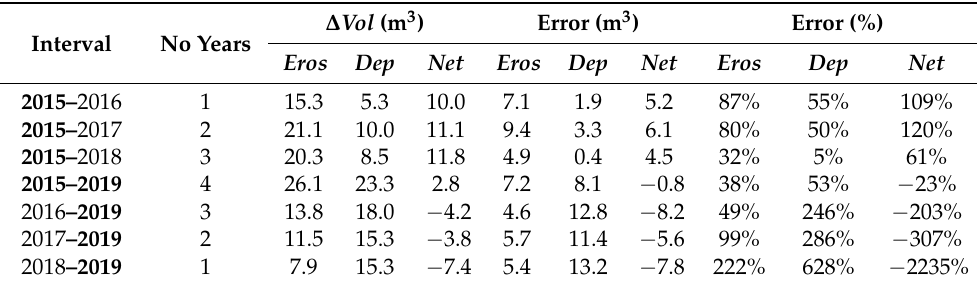
Table A5. Volumetric change ∆ Vol (m 3 ) in areas of deposition and erosion for each HLS year interval. Errors are relative to equivalent measures from TLS (Table 4). Eros = erosion, Dep = deposition, Net = Erosion–Deposition. Bolded year is reference year used. Data below are represented graphically in Figure